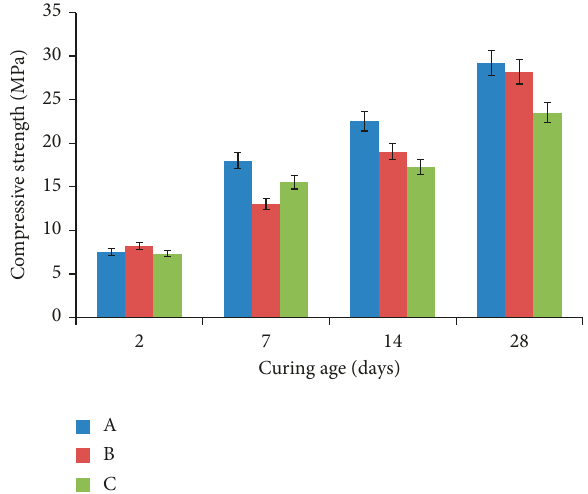
Figure 3: Compressive strength at 2, 7, 14, and 28days for all brands of OPC at w/c 0.65.